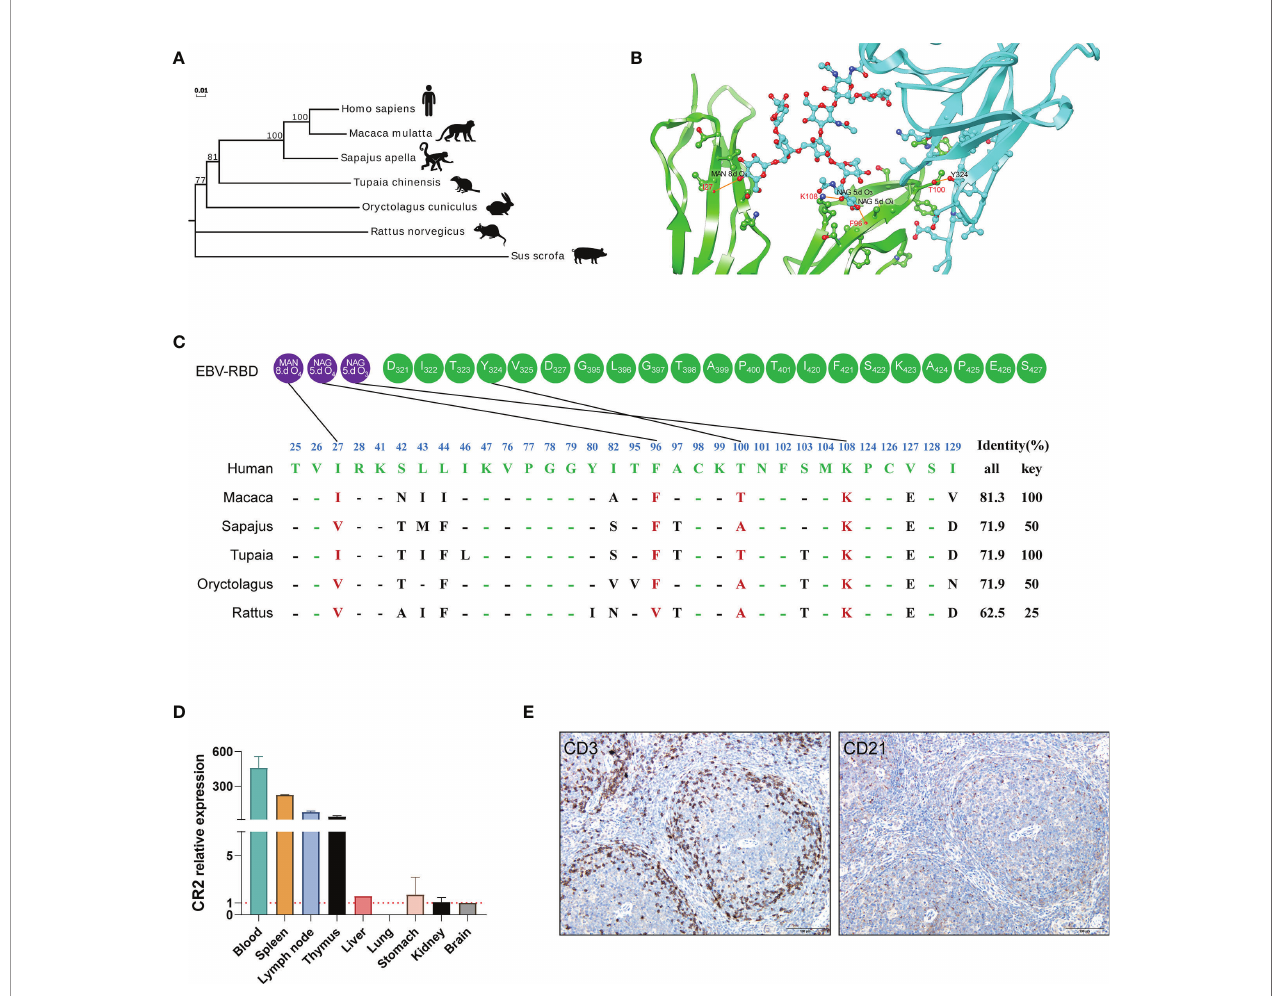
FIGURE 2 | The potential residues in CR2 that restrict EBV entry. (A) A phylogenetic tree (constructed using the Neighbor-joining method in program MEGA7) based on the protein sequences of CR2 orthologs. (B) Cartoon of the binding interface between human CR2 and the EBV receptor-binding domain (RBD). CR2 and the EBV RBD are colored in green and azure, respectively. The interaction among key residues (I27, F96, K108, and T100) are shown as ball-and-stick representations. (C) Alignment of the residues of humans, Macaca, Sapajus, Tupaia, Oryctolagus, and Rattus SCR1-SCR2(two CR2 repeats regions where EBV glycoprotein gp350/220 attaches) at the interface of SCR1-SCR2 with the EBV-gp350. Purple circles represent the viral glycoproteins and Green circles represent the viral amino acid residues. MAN and NAG represent binding site for the glycoprotein residue, respectively. 8.d O4, 5.d O4 and 5.d O3 represent the speci fi cs locations of oxygen atoms which form hydrogen bonds. The restrictive residues of the Macaca, Sapajus, Tupaia, Oryctolagus, and Rattus SCR1-SCR2 are highlighted in red. Favorable residues of human SCR1-SCR2 are highlighted in green. “ All ” represents the sequence identity of SCR1-SCR2 between humans and the other species, whereas “ Key ” represents the sequence identity of key residues between humans and the other species. (D) RT-qPCR detection of CR2 RNA in the indicated tissues from healthy tree shrews, brain tissue served as a negative control. (E) IHC detection of CD3 and CD21 proteins of the spleen of healthy tree shrew, positive proteins are shown in